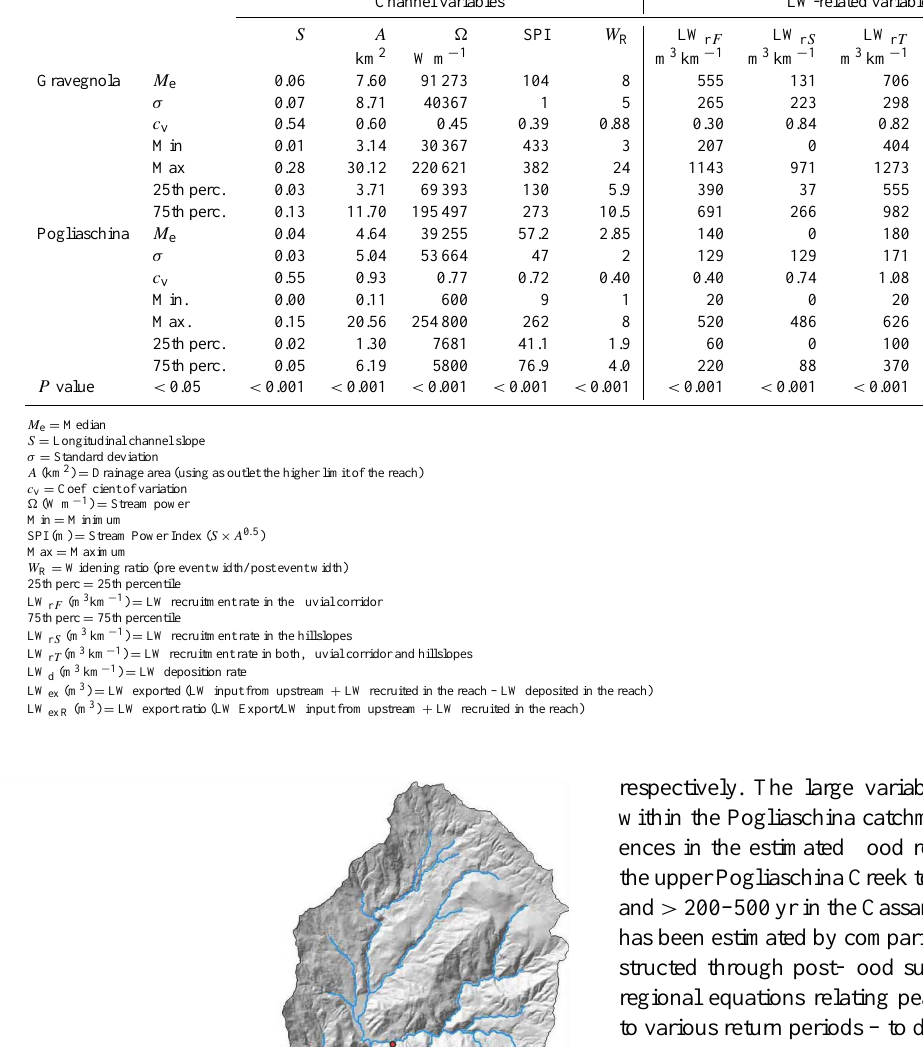
Table 2. Summary of the channel and LW-related variables analysed statistically at the reach scale. Channel variables LW-related variables